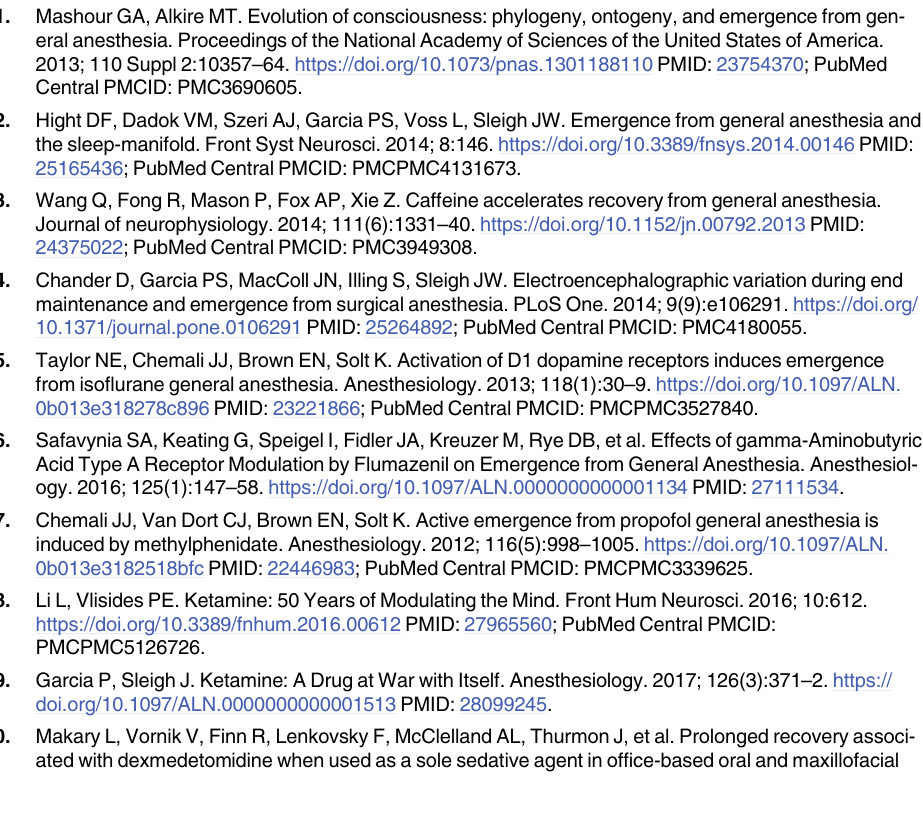
solid lines) and recovery period (RORR to sticky dot notice, dashed lines) is plotted on the lower graph. SAL = blue, YOH = red, ATI = purple, K/I-SAL = yellow, ATI+PRA = green. Mean values are plotted. Vertical dashed gray line represents time of reversal agent injection.